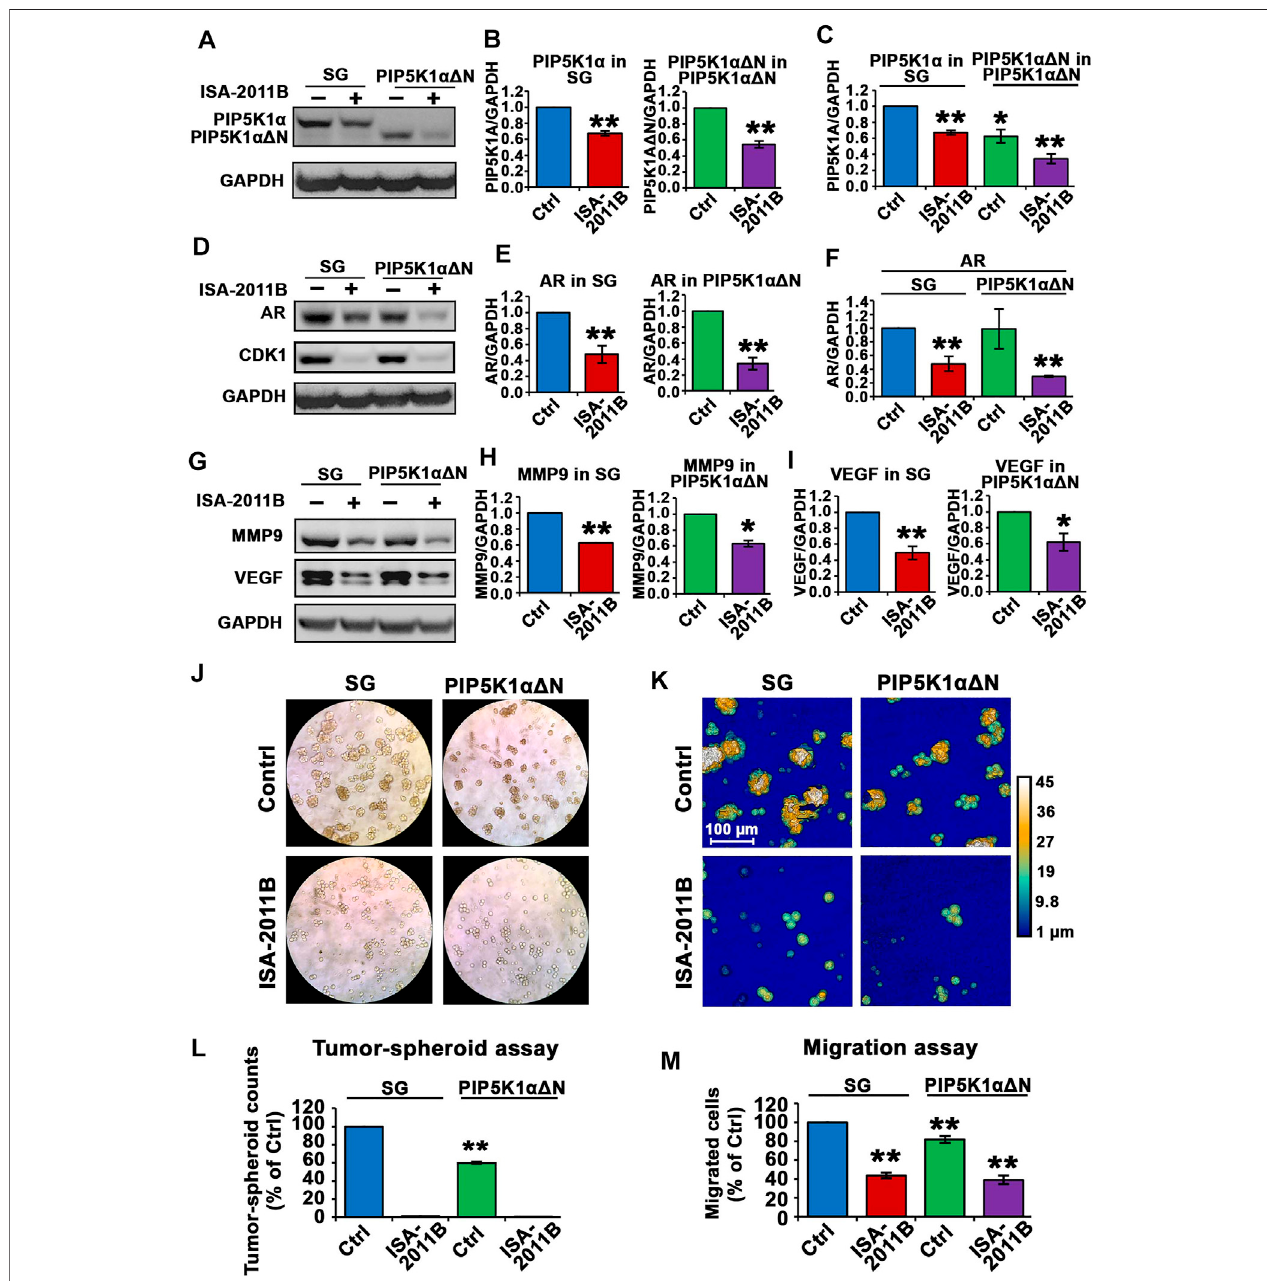
FIGURE 9 | The effect of ISA-2011B on the downstream effectors of PIP5K1 α and growth in SG and PIP5K1 αΔ N cells. (A – F) The effect of ISA-2011B on the expression ofPIP5K1 α ,ARandCDK1 inPIP5K1 αΔ Ncells andSGcellswasdetermined usingimmunoblot analysis.Quanti fi cationsoftheimmunoblotsofPIP5K1 α and AR in SG or PIP5K1 αΔ N cells treated with DMSO or ISA-2011B are shown in the right panels. (G – I) The effect of ISA-2011B on the expression of MMP9 and VEGF in PIP5K1 αΔ N cells and SG cells was determined using immunoblot analysis. Quanti fi cations of the immunoblots of the proteins in SG or PIP5K1 αΔ N cells treated with DMSO or ISA-2011B are shown in the right panels. (J) Representative images of the tumor-spheroids derived from SG cells or PIP5K1 αΔ N cells that were treated with DMSO (Control) or ISA-2011B are shown. (K) Representative images of the tumor spheroids were taken using the digital Holomonitor M4. (L) The counts of tumor spheroids derived from SG or PIP5K1 αΔ N cells treated with DMSO or ISA-2011B are shown. (M) The effect of ISA-2011B on the migratory ability of SG cells or PIP5K1 αΔ N cells was determined using migration assays. Data in this fi gure is presented as the average of three independent experiments (±SE). Student ’ s t -test was used in the analysis. * p < 0.05 or ** p < 0.01 are